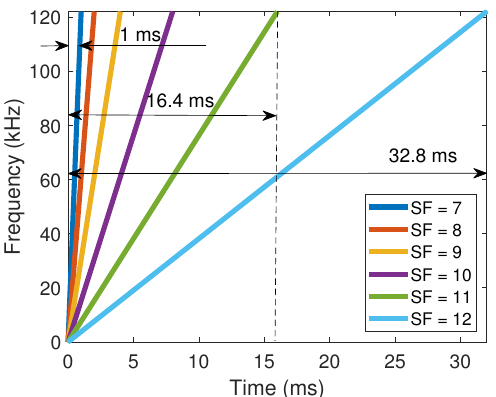
Figure 2. Time–frequency plot of six raw LoRa upchirps, each one with a given